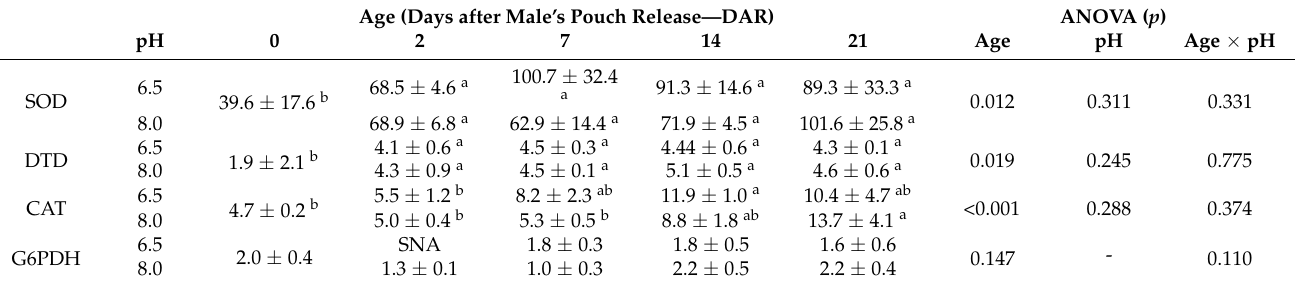
Table 6. Trial 1 (BW)—Enzymatic activities (mean ± s.d.) in H. reidi juveniles reared in brackish water (BW—salinity 11) at pH 6.5 or 8.0 for 21 days (age 0–21 DAR—days after the male’s pouch release).